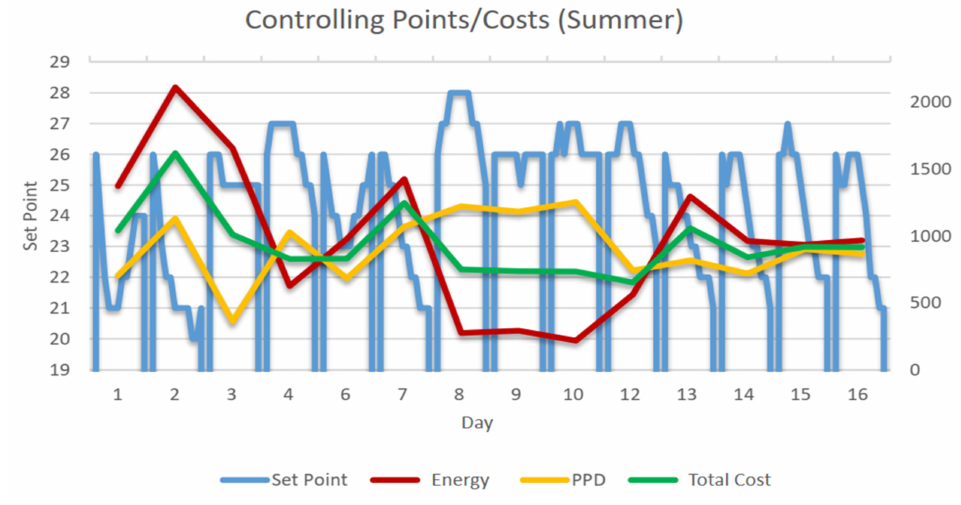
Figure 12. Controlling points/costs